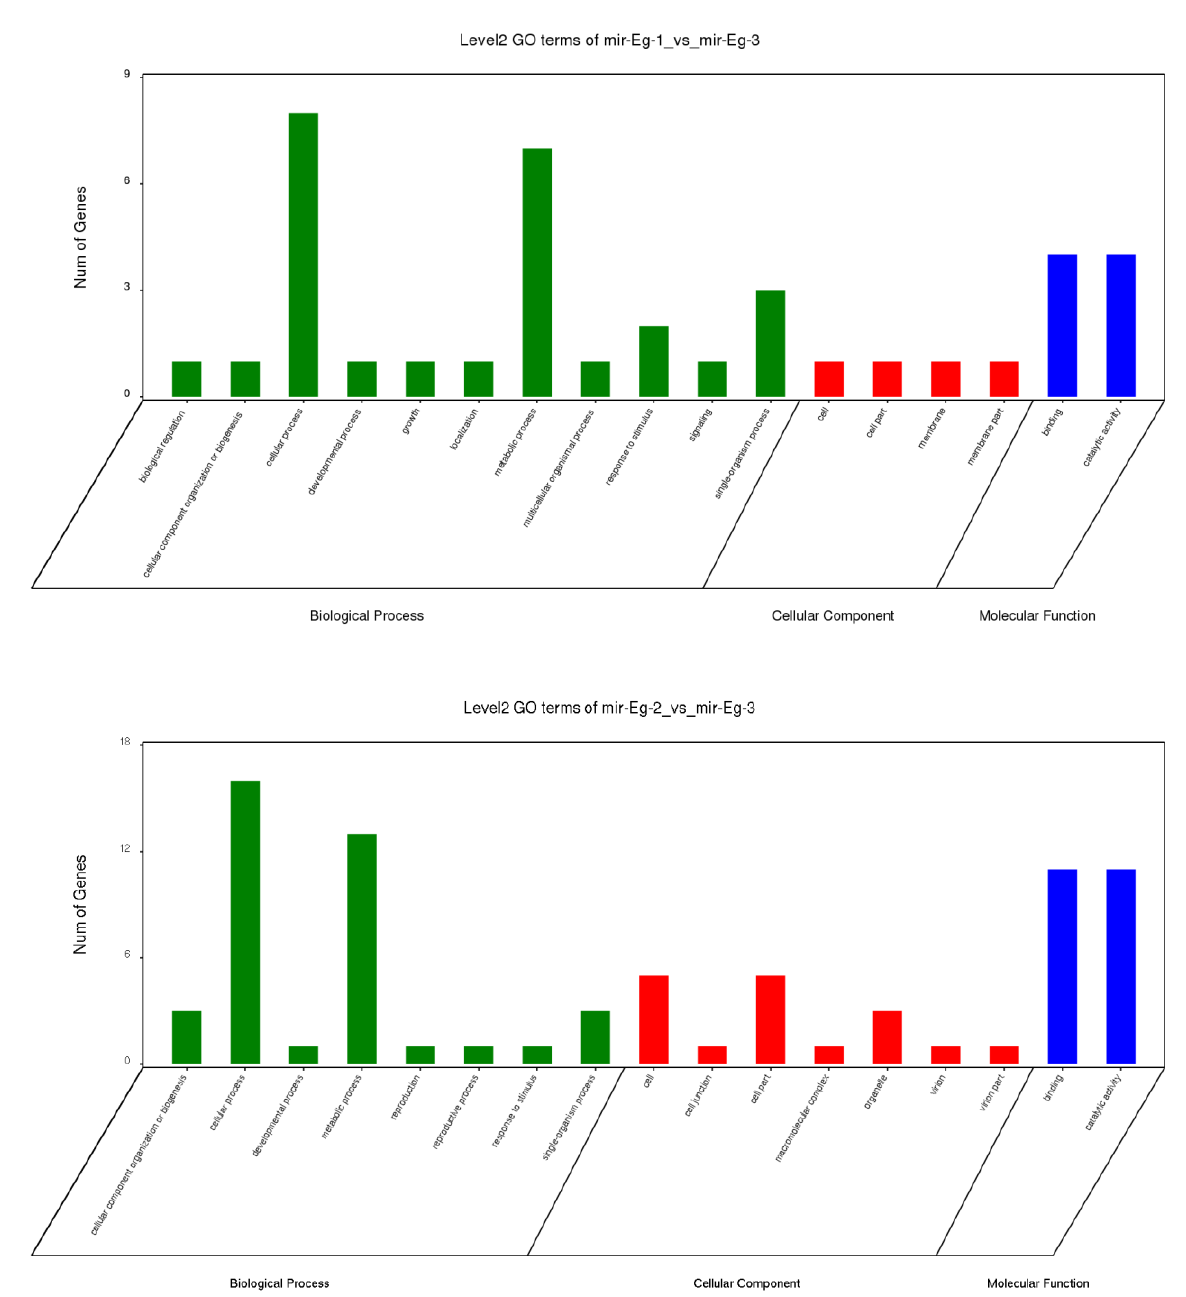
Figure 3. GO enrichment analysis of target genes in differentially expressed miRNAs between groups.